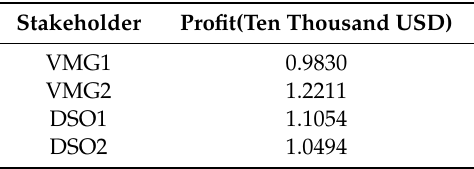
Table 4. Maximum benefits when each stakeholder is independently